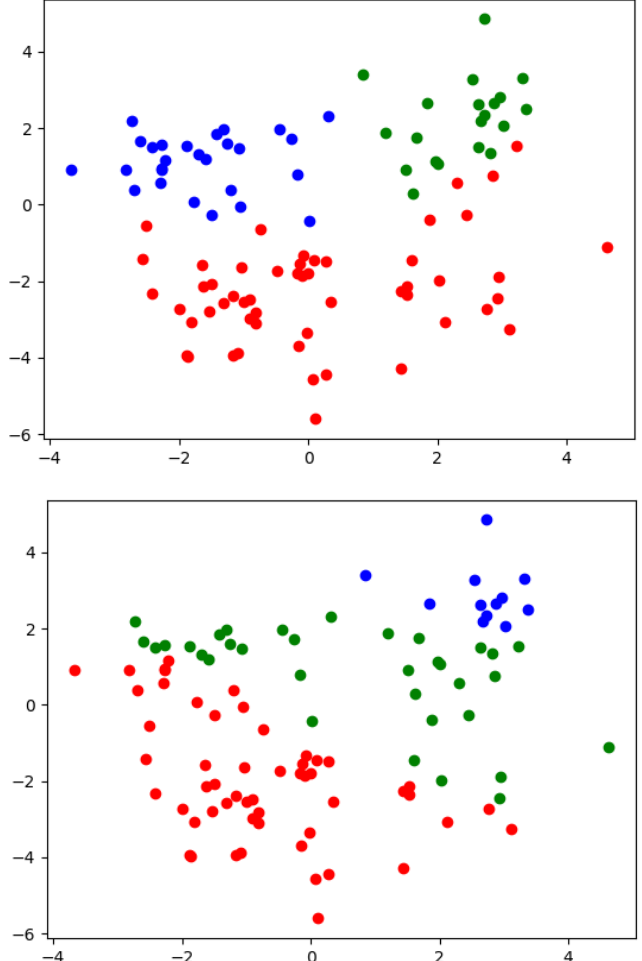
Figure 2. Comparison of an irregular set clustered by the proposed algorithm ( upper figure ) and K - means algorithm ( bottom figure ).